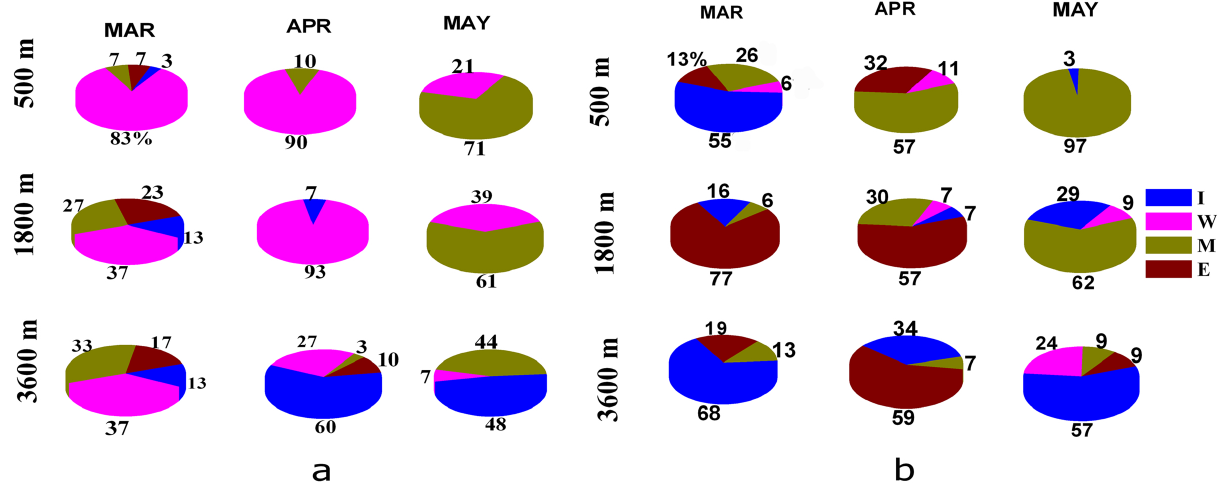
Fig. 31. Pie-chart representation of the percentage contribution from the different groups of trajectories depicted in Fig. 30, for three altitudes (500m, 1800m and 3600ma.s.l.) for March, April and May over the two island stations of (a) Minicoy and (b) Port Blair (from Beegum et al., 2008, copyright 2008 by the Indian Academy of Sciences, reproduced with